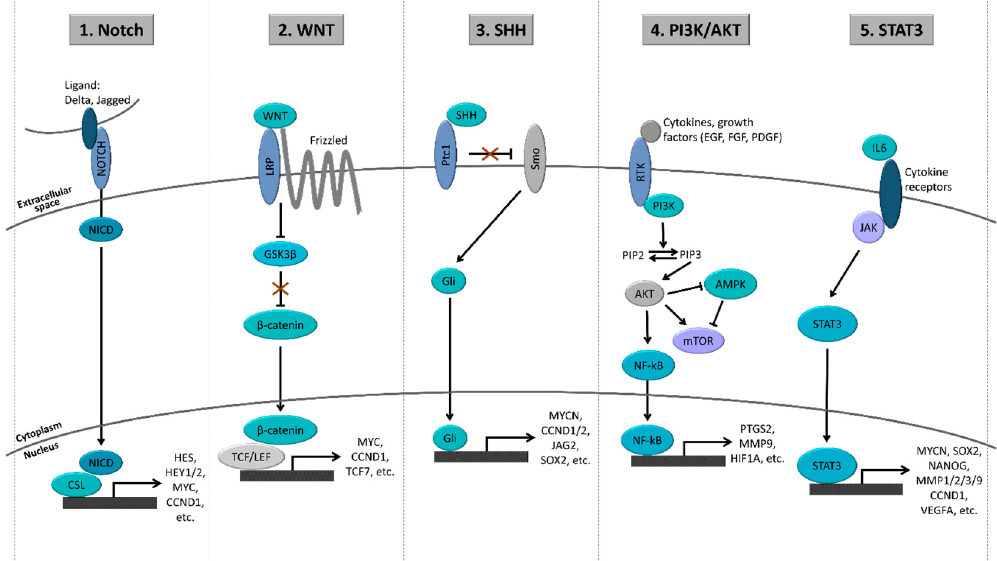
Figure 2. Simplified scheme of critical signaling pathways involved in glioma stem cell (GSC) maintenance. GSCs co-opt several signaling pathways that are also crucial in normal stem cells (e.g., Notch, WNT, SHH, PI3K/AKT, and STAT3 pathways), which hinders a straightforward distinction between cancer and normal stem cells.